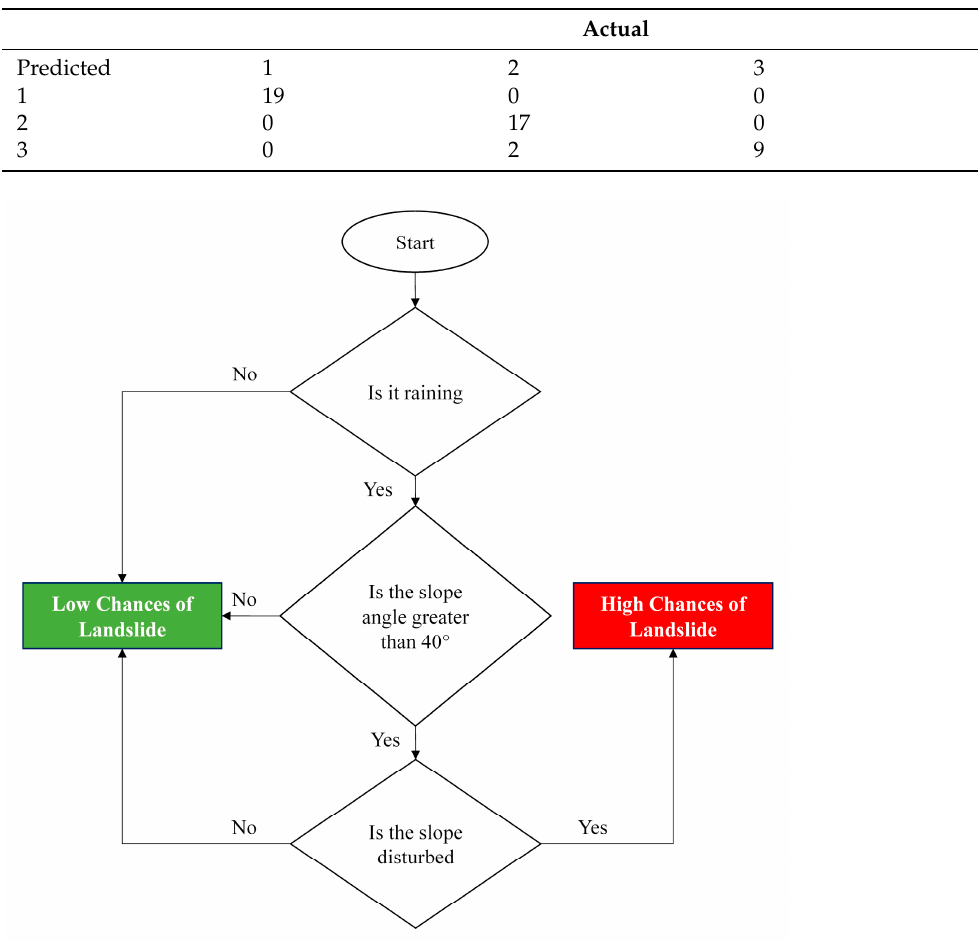
Table 10. Confusion matrix for decision tree algorithm used in assessing the best algorithm for the LEWS (Testing data).